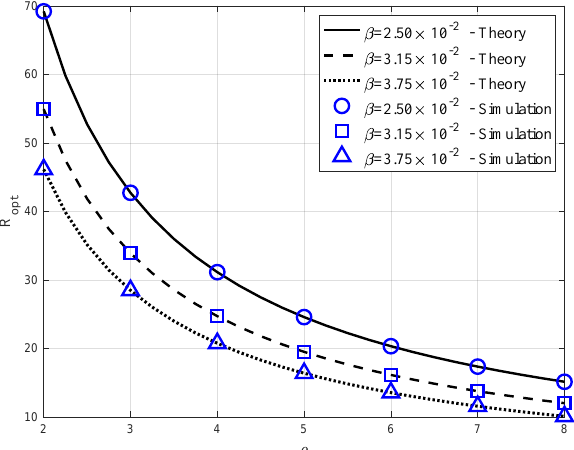
Figure 8. Optimal radius R opt versus ρ = L / R , when λ = 10 − 3 and β = { 2.5 × 10 − 2 , 3.15 × 10 − 2 , 3.75 × 10 − 2 }